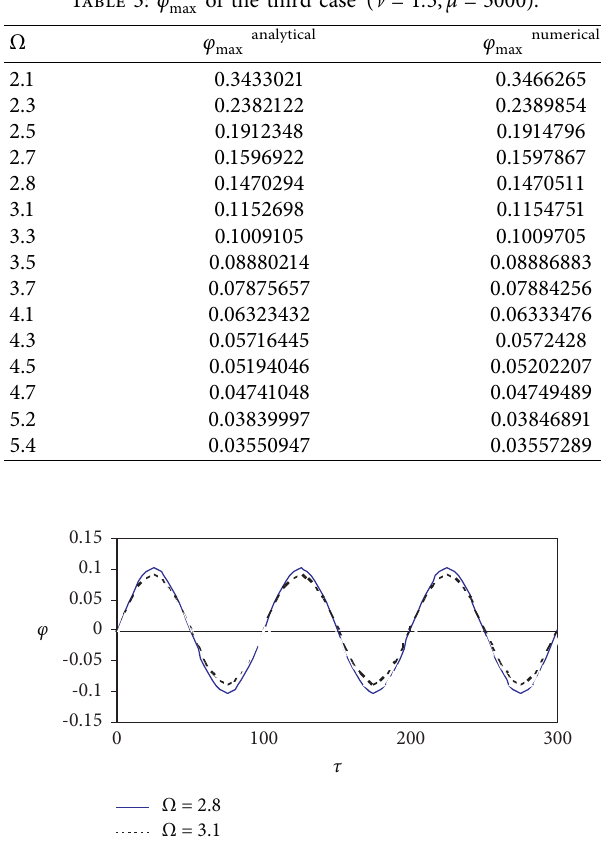
Figure 8: The analytical solutions for case (iii) in Section